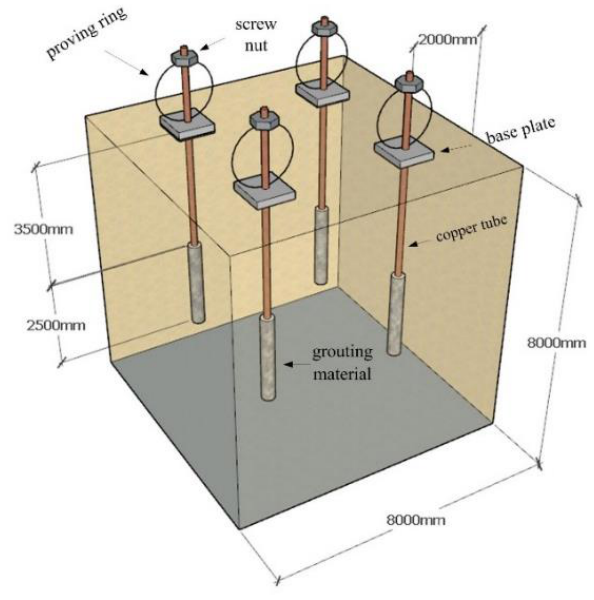
Table 1. Physical and mechanical parameters of yellow clay sand.